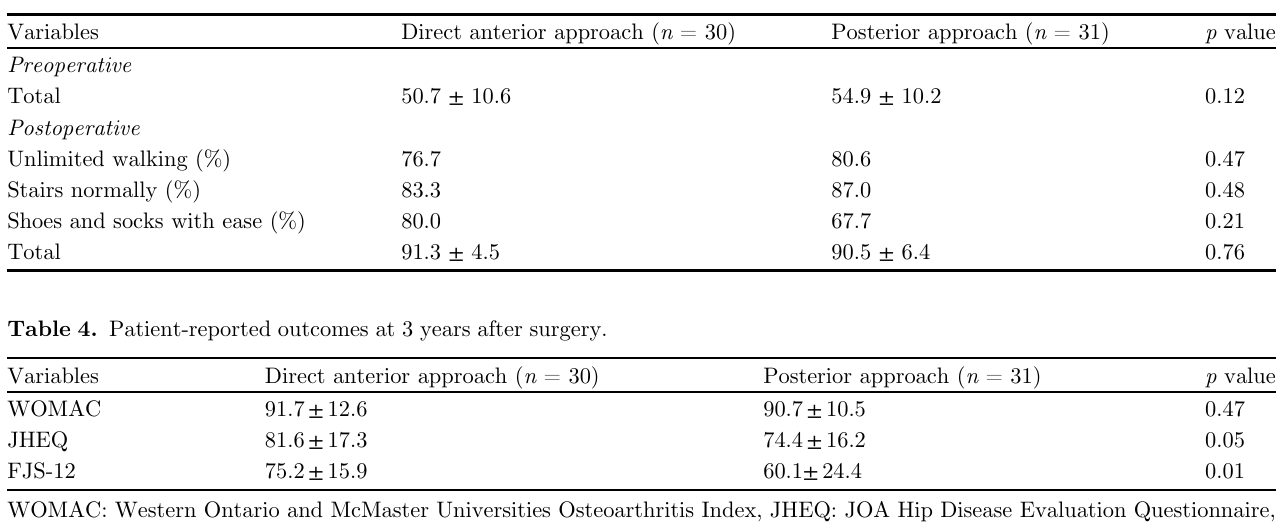
Table 3. Harris hip score of before surgery and at 3 years after surgery.